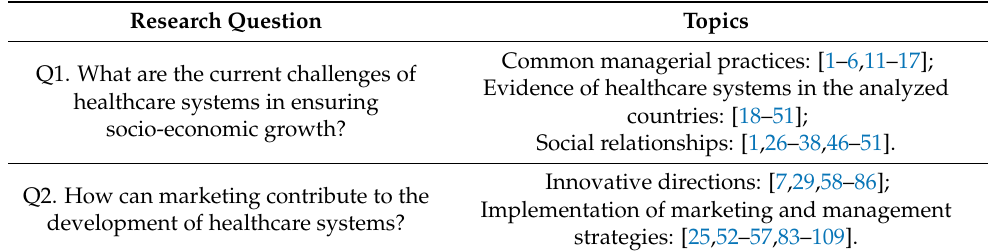
Table 4. Synthesis of individual